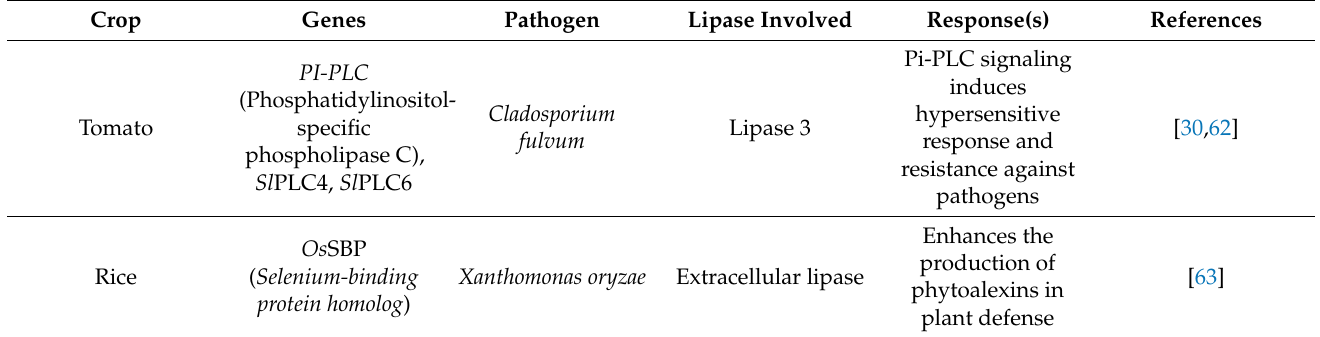
Table 2. Molecular regulation and response strategies of plants upon successful invasion by pathogens. Crop